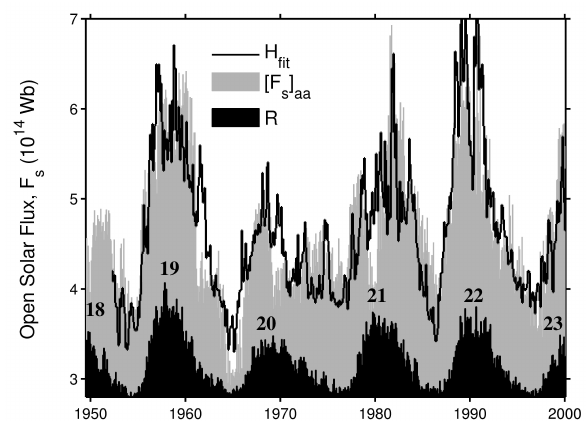
Figure 2. Variations of monthly means of solar, heliospheric and cosmic ray data since 1950. The grey histogram gives the open solar magnetic flux [Fs] aa , deduced from the aa geomagnetic index using the method of Lockwood et al. (1999a; b). The black line is H FIT the best fit of the anti-correlated cosmic ray counts H , observed by the equatorial Huancayo and Hawaii neutron monitors (which form a homogeneous data sequence on positively-charged GCRs with rigidities exceeding 13GV). The black histogram gives the sunspot number, R for comparison.